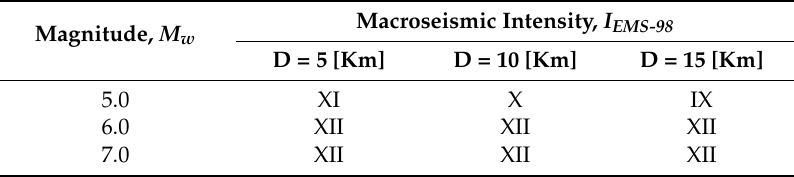
Table 2. Correlation between moment magnitude, M w , and macroseismic intensities, I EMS-98 , for different epicentre distances.